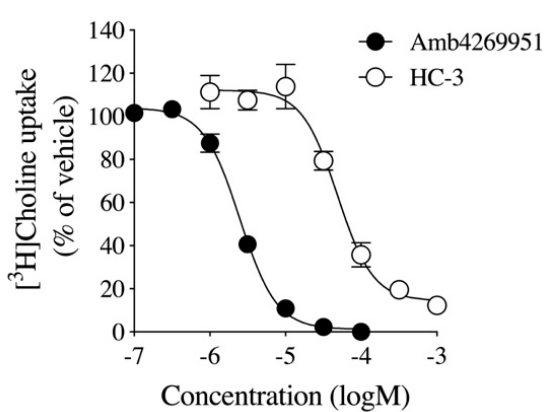
Figure 2. The effect of Amb4269951 and HC-3 on [ 3 H]choline uptake in U251MG cells. Cells were pre-incubated with various concentrations of Amb4269951 and HC-3 for 20 min, and the uptake of 10 µM [3H]choline was then measured for 20 min. The results are given as a percentage of the control uptake measured in the presence of the vehicle. Each point represents the mean ± SD ( n = 3). The IC 50 values of Amb4269951 and HC-3 for the inhibition of [ 3 H]choline uptake were 2.5 and 48.6 µM, respectively.